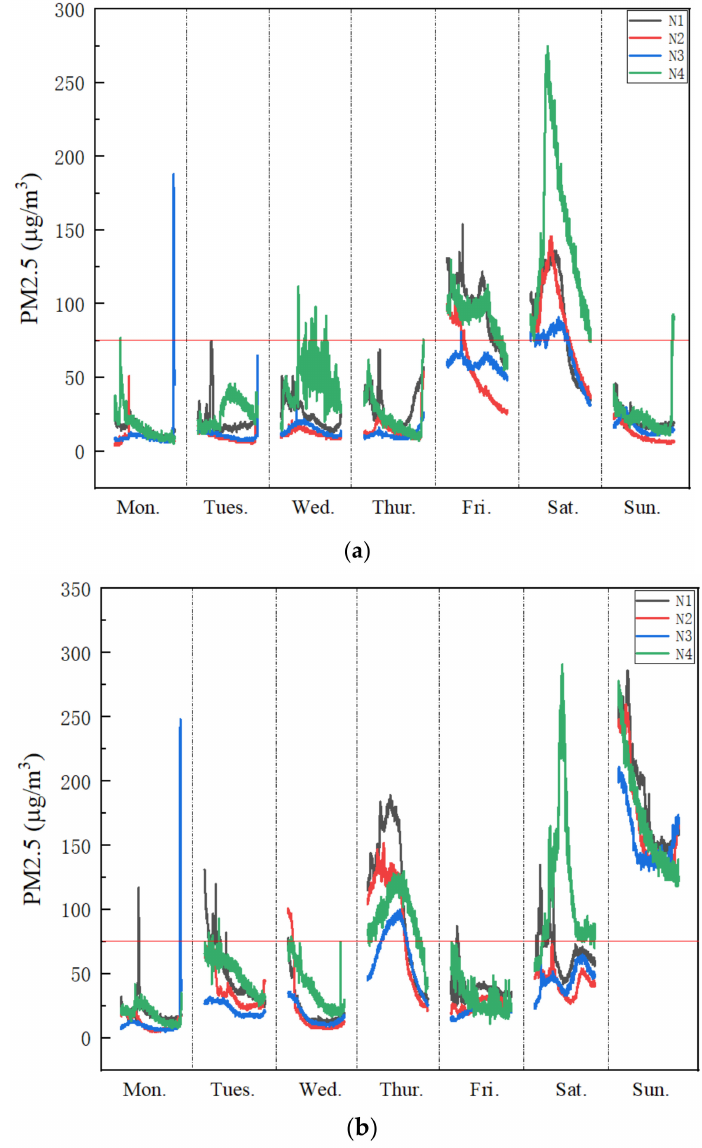
Figure 10. PM 2.5 measurement results. ( a ) Before heating, ( b ) After